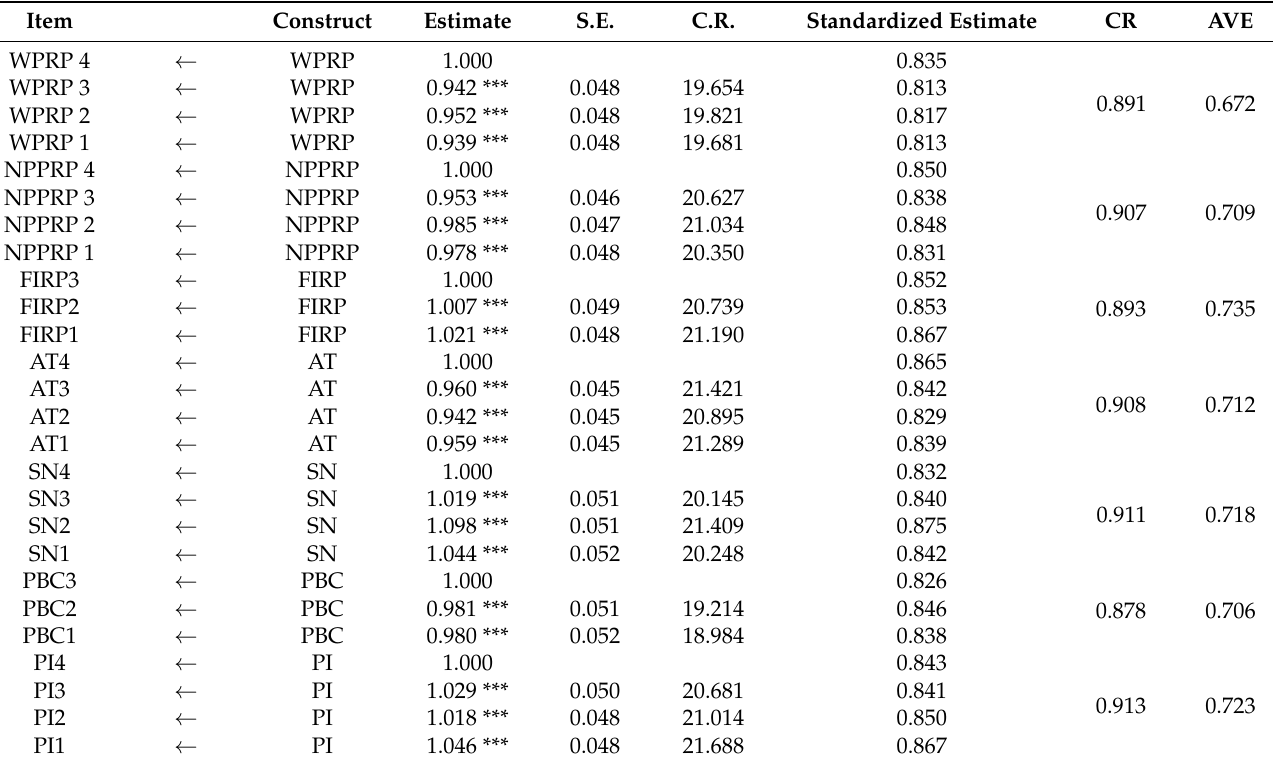
Table 3. Convergent validity.